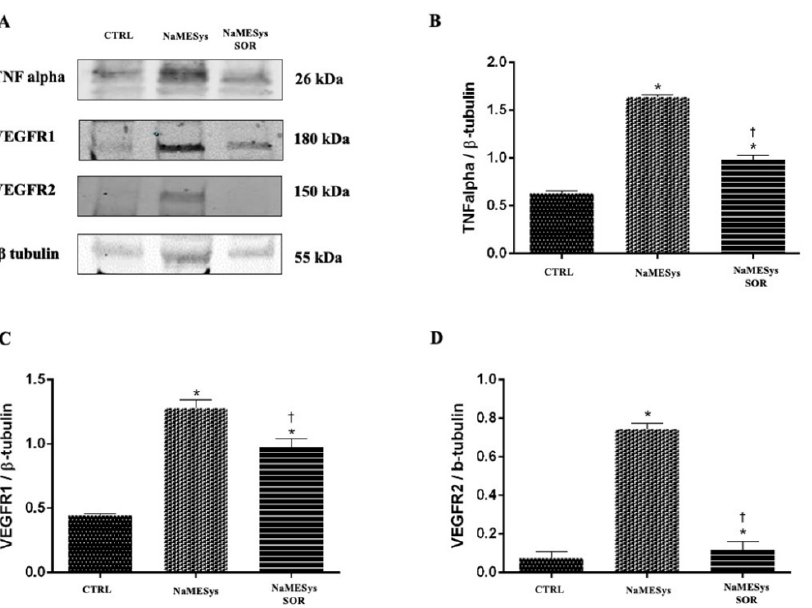
Figure 4. Tumor necrosis factor-alpha (TNF α ), vascular endothelial growth factor receptor 1 (VEGFR1) and vascular endothelial growth factor receptor 2 (VEGFR2) protein expression in retinas of diabetic rats treated with nanostructured microemulsions system carrying 0.3% sorafenib (NaMESys-SOR). ( A ) Representative immunoblots of TNF α , VEGFR1 and VEGFR2 expression in retinas of control non-diabetic rats treated with vehicle NaMESys (CTRL, n = 12), diabetic rats treated with vehicle NaMESys (NaMESys, n = 12) and diabetic rats treated topically with NaMESys-SOR for 21 days (NaMESys-SOR, n = 12). Densitometric analyses of immunoblots for ( B ) TNF- α , ( C ) VEGFR1, ( D ) VEGFR2. Protein levels are expressed as arbitrary units obtained after normalization to β -tubulin which was used as loading control. Data are presented as mean ± SD. * p < 0.05 vs. CTRL or † p < 0.05 vs. NaMESys. One-way ANOVA followed by Tukey–Kramer’s post-hoc test.